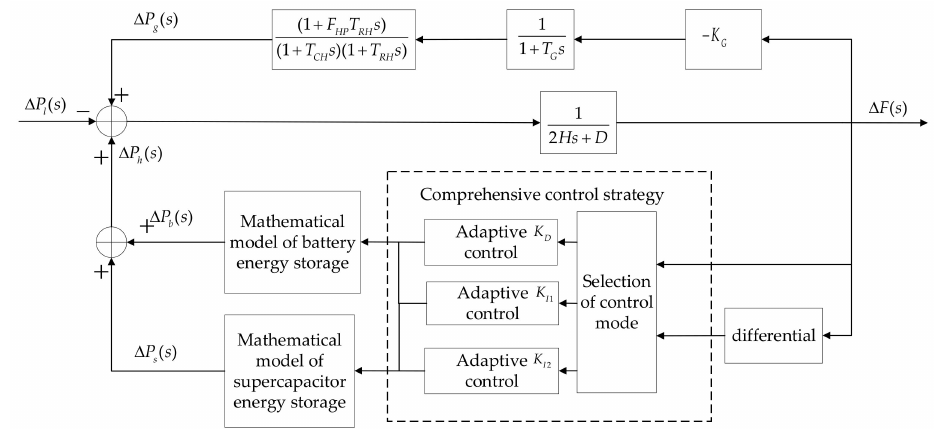
Figure 1. Regional power grid frequency modulation model with HES participating in PFM.